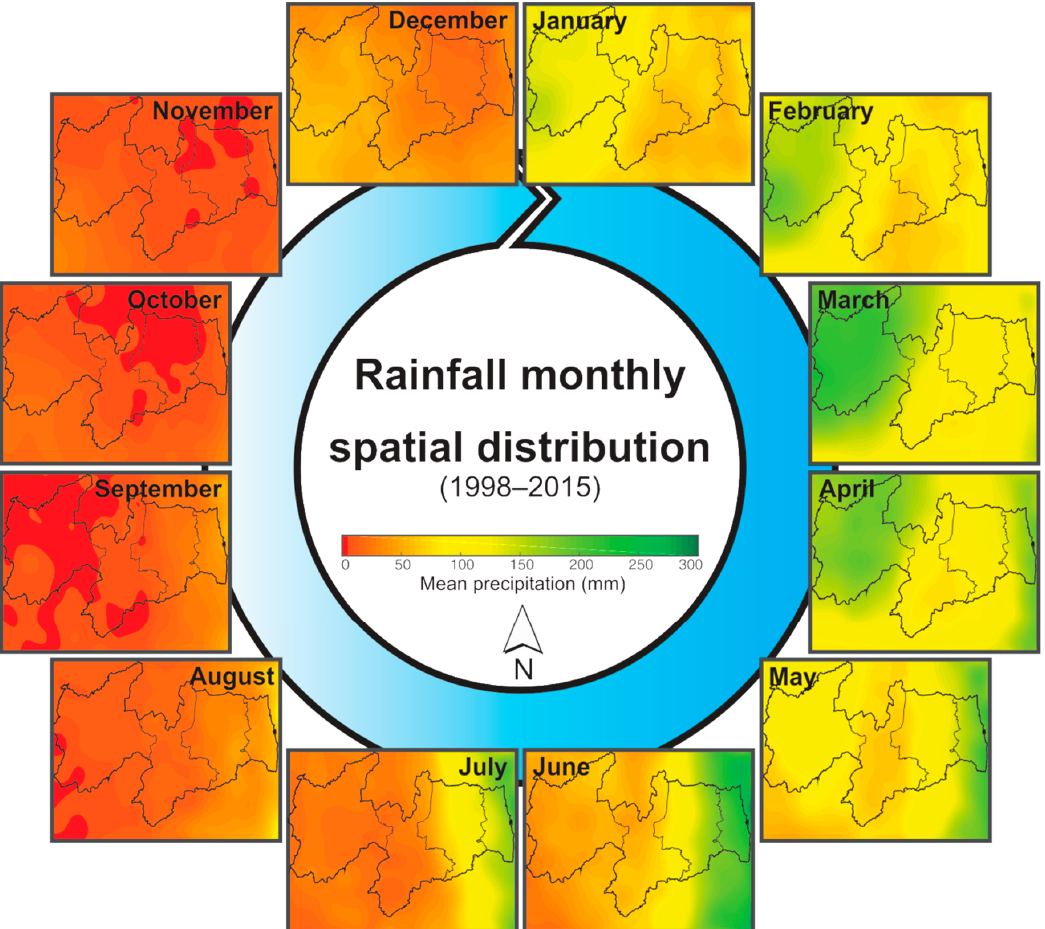
Figure 3. Spatial distribution of mean monthly TRMM precipitation in Paraíba (1998–2015).